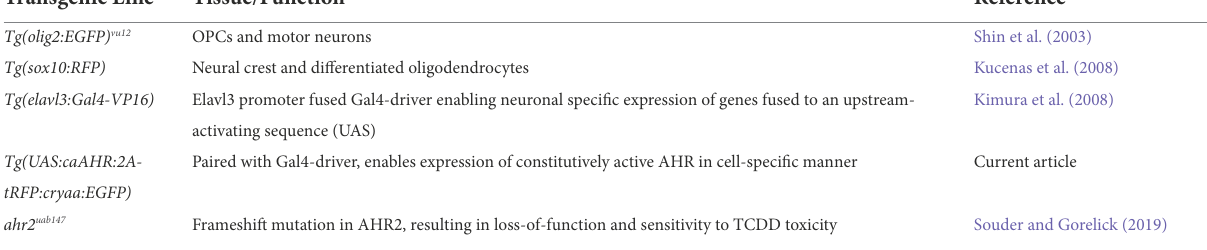
TABLE 1 Transgenic Danio Rerio lines used in manuscript. Transgenic